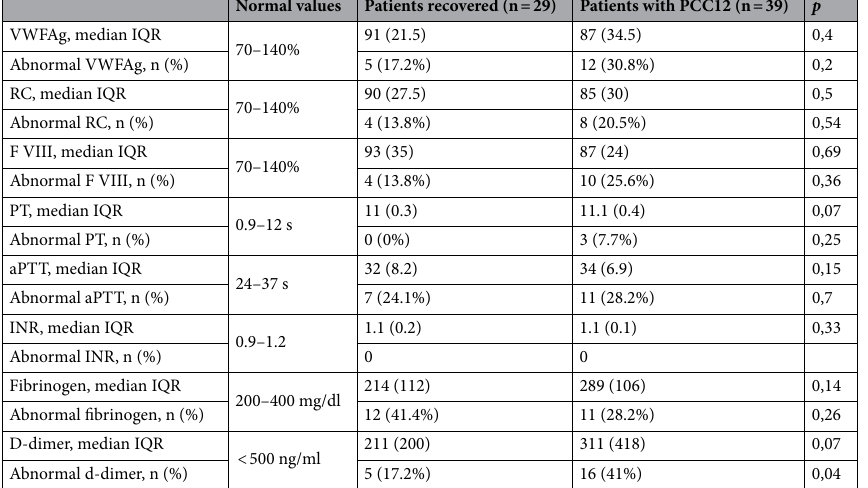
Patients without persistence of more than 3 symptoms Normal values (PCC ≥ 3) and follow-up of at least 12 weeks (n = 54)